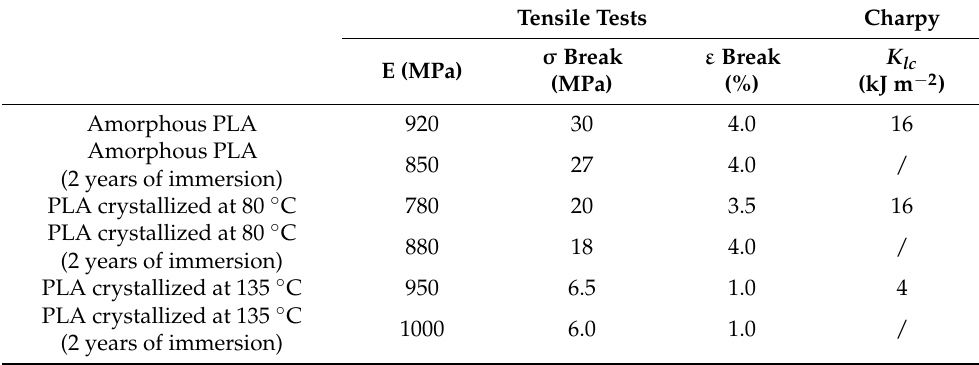
Table 2. Young’s Modulus (E), stress at break ( σ ), strain at break ( ε ), and toughness ( K lc ) from mechanical tests.